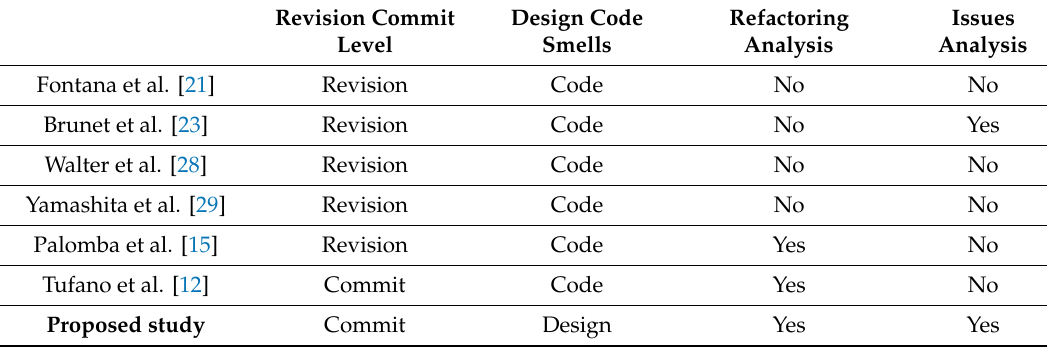
Table 1. Related work